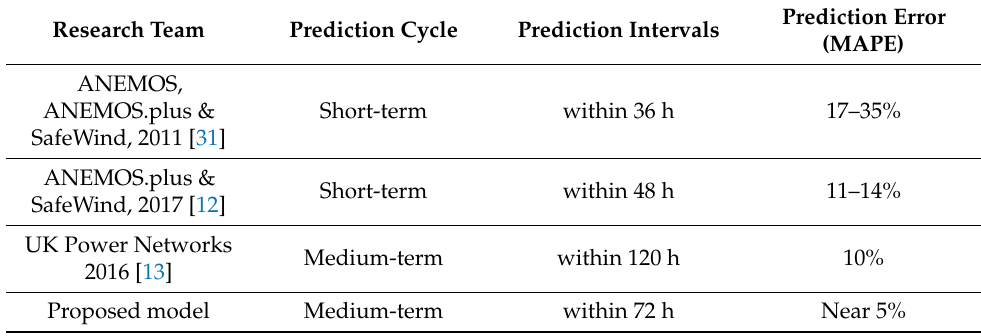
Table 11. Performance comparison of other real projects for wind power